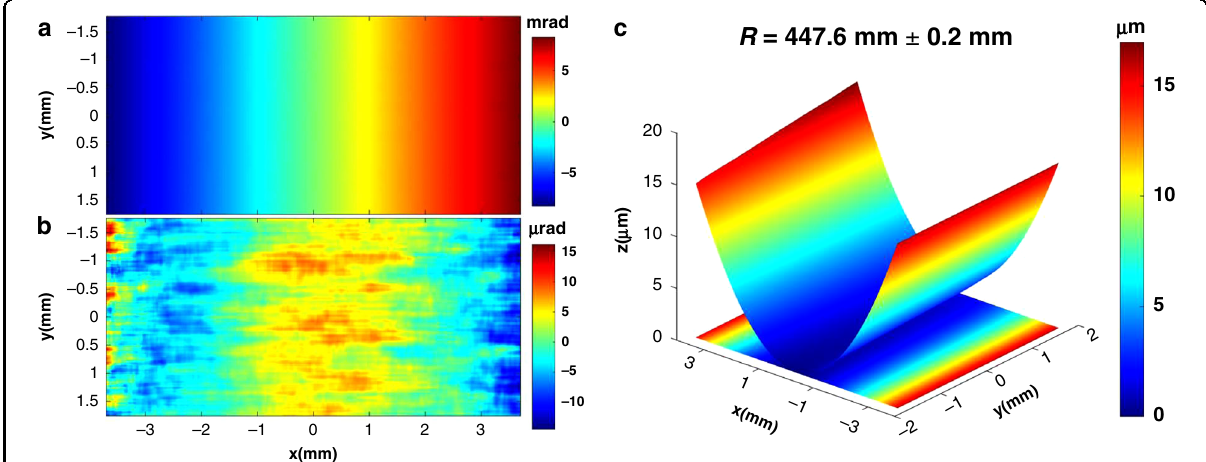
Fig. 8 Measured 2D surface pro fi les of a strongly curved cylinder mirror. a Mirror sagittal slope ( b ) mirror sagittal slope error, and ( c ) height pro fi le images of the strongly curved cylinder mirror. The measured mirror slope range is above 16.5 mrad over 7.4 mm, and the measured slope error and the measured radius of curvature of mirror are 4.2 urad and 447.6 ± 0.2 mm, respectively. Note the change of de fi nition: x is here the sagittal coordinate and y the tangential coordinate of the